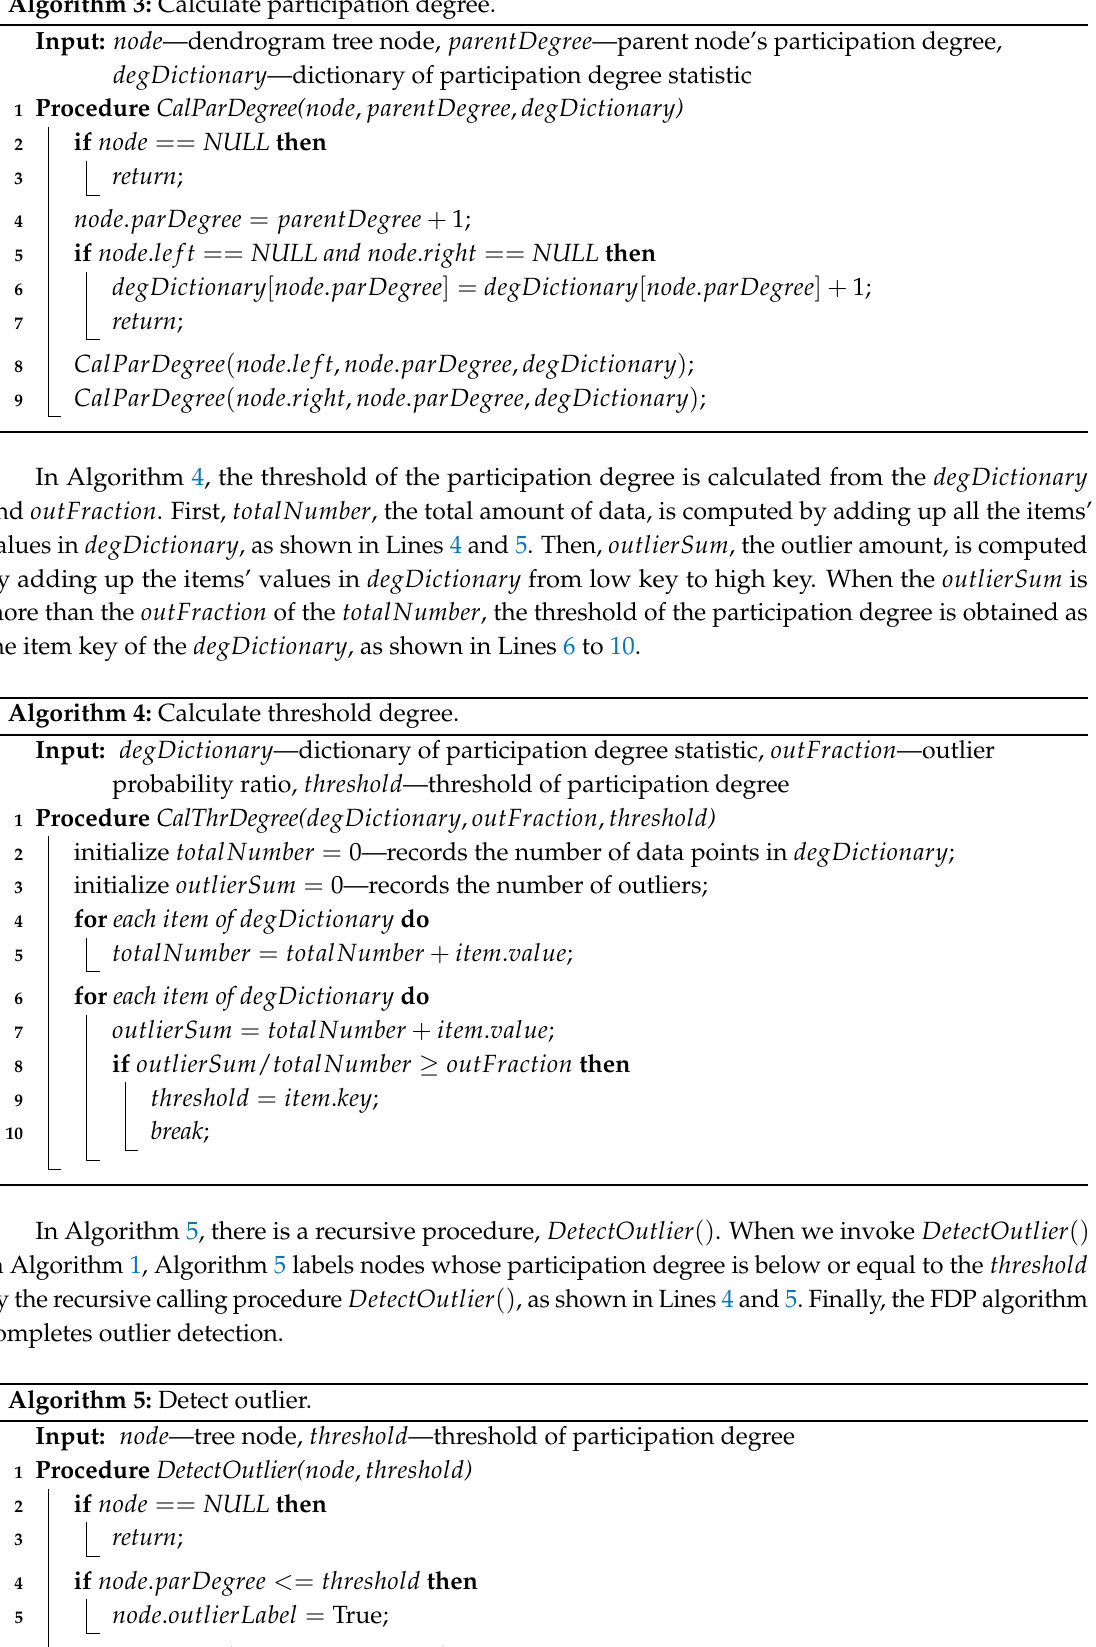
Algorithm 3: Calculate participation degree.